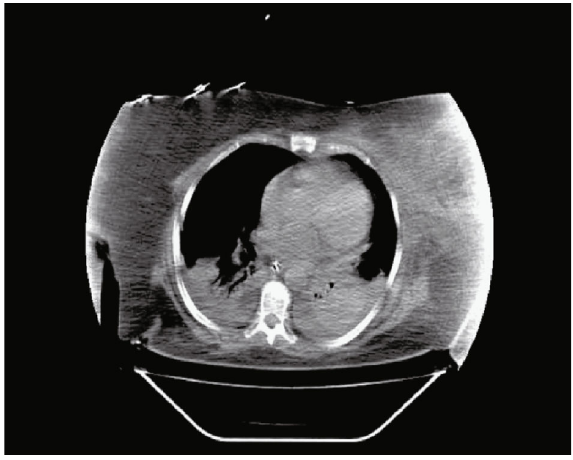
Figure 2: Chest tomography showing bilateral pleural e ff usion, bilateral basal subsegmental atelectasis, and generalized ground glass opaci fi